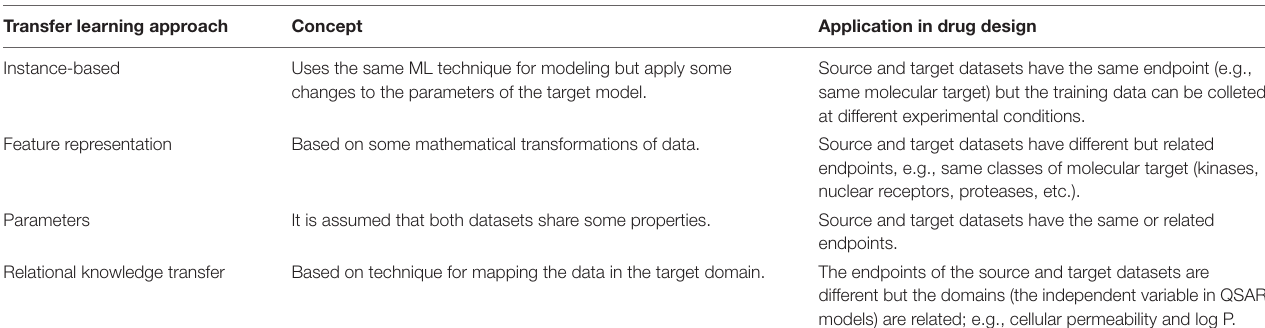
TABLE 1 | Examples of potential applications of transfer learning methods in drug